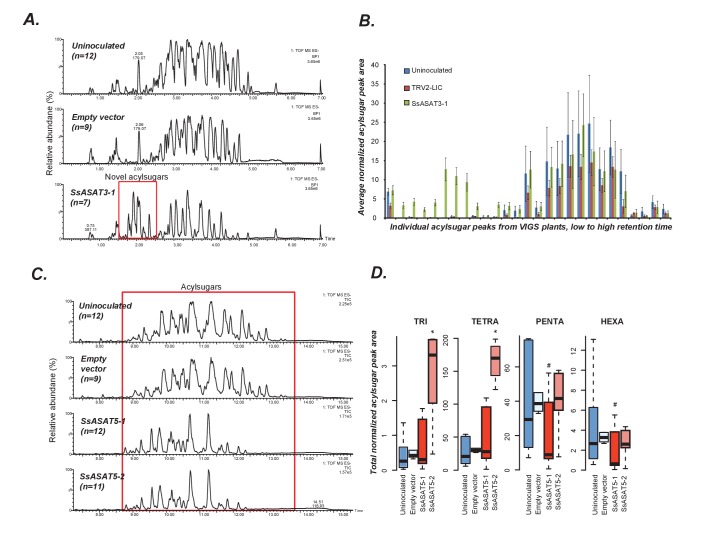
VIGS phenotypes of SsASAT3 and SsASAT5 knockdown plants.In each sub-figure, the left hand panel shows a representative chromatographic phenotype while the right hand panel shows distributions of the aggregated peak areas of all plants of the tested genotypes. (A,B) SsASAT3 VIGS knockdown experiment using a single targeting fragment SsASAT3-1 resulted in appearance of novel acylsugar peaks whose levels are significantly higher (p<0.05, KS test) vs. control. Error bars indicate standard error. Individual acylsugar peak areas are shown in Figure 4—figure supplement 1, while positive mode fragmentation patterns of the novel acylsugars are shown in Figure 4—figure supplement 2. (C) SsASAT5-1 and SsASAT5-2 chromatograms are from individual plants with two different regions of the SsASAT5 transcripts targeted for silencing. (D) Distributions of the aggregated peak areas of all plants of the tested genotypes. The boxplots show that SsASAT5 knockdown leads to a significant (*: KS test p<0.05; #: KS test 0.05 < p < 0.1) accumulation of tri-and tetra-acylsugars, and the effect is prominent in the SsASAT5-2 construct. A graphical explanation of the SsASAT3 and SsASAT5 knockdown results is presented in Figure 4—figure supplement 3.